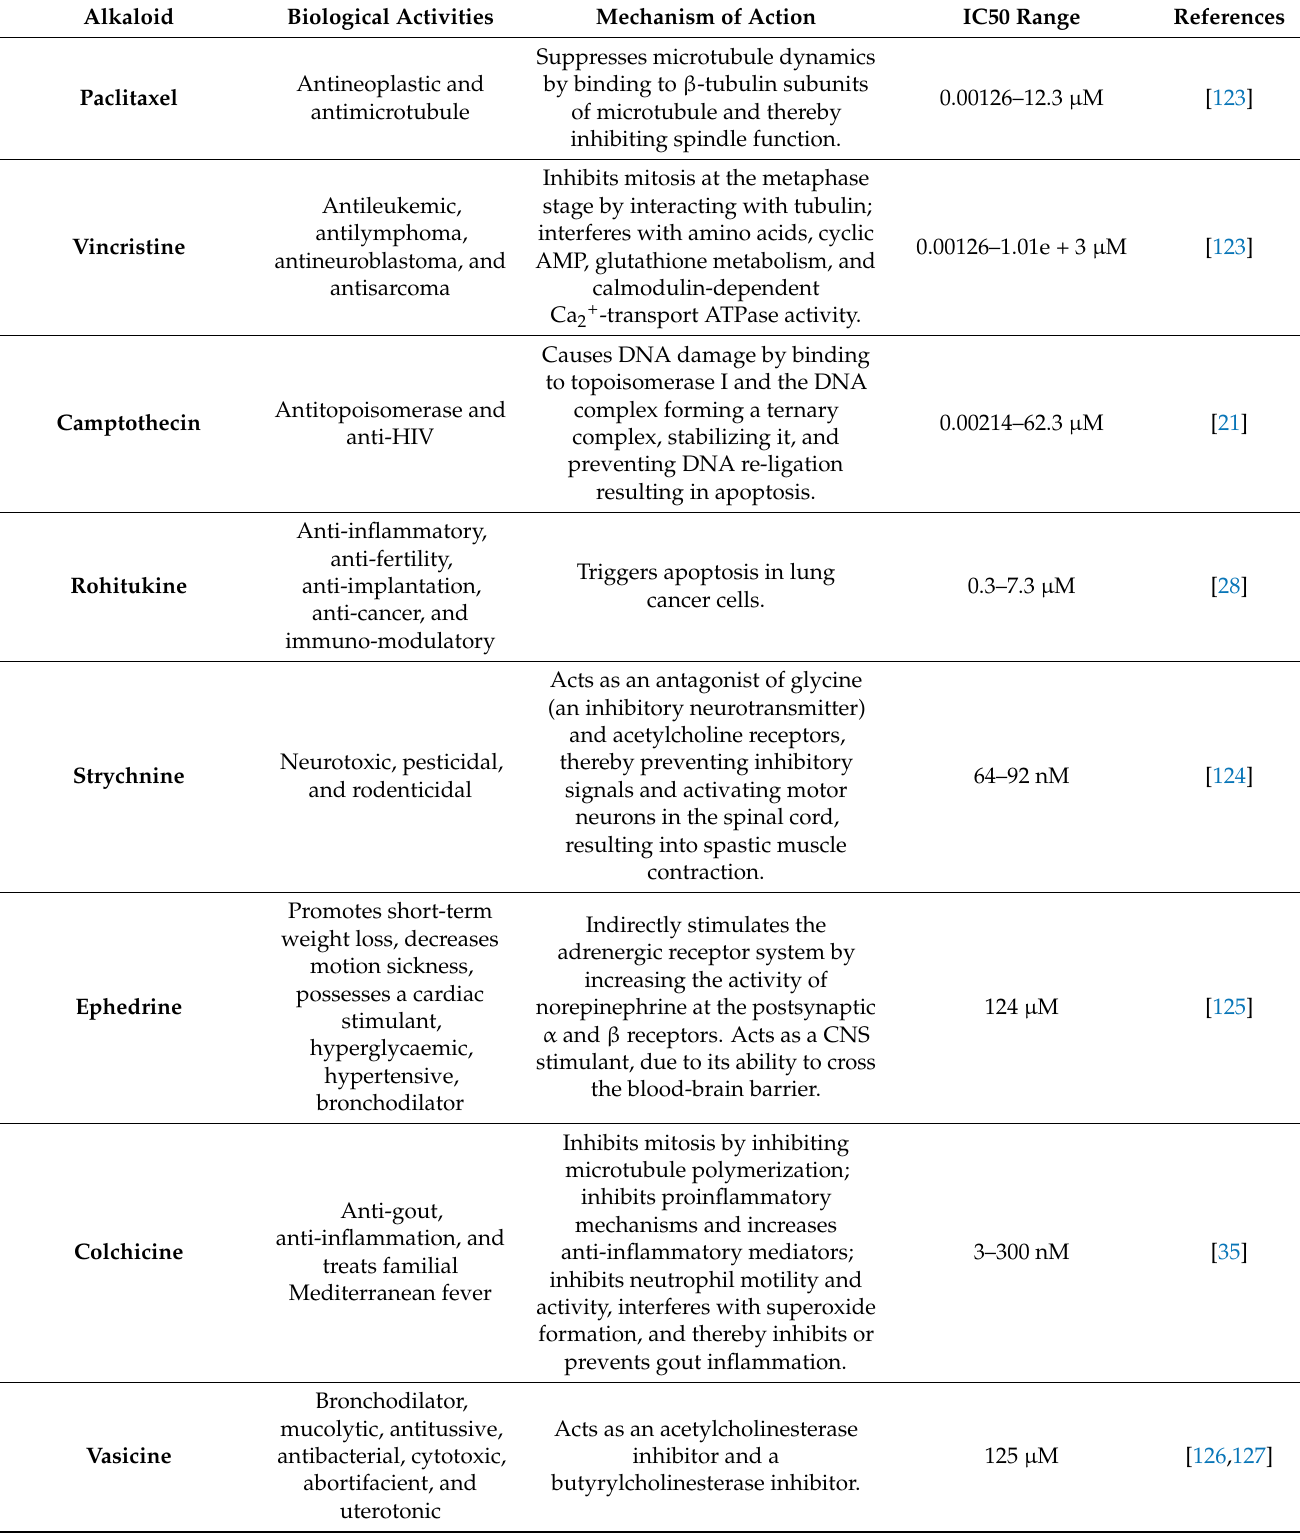
Table 2. The biological activities of alkaloids. Numerous biological activities of alkaloids present in plants, their mechanism of action, and IC50 values are